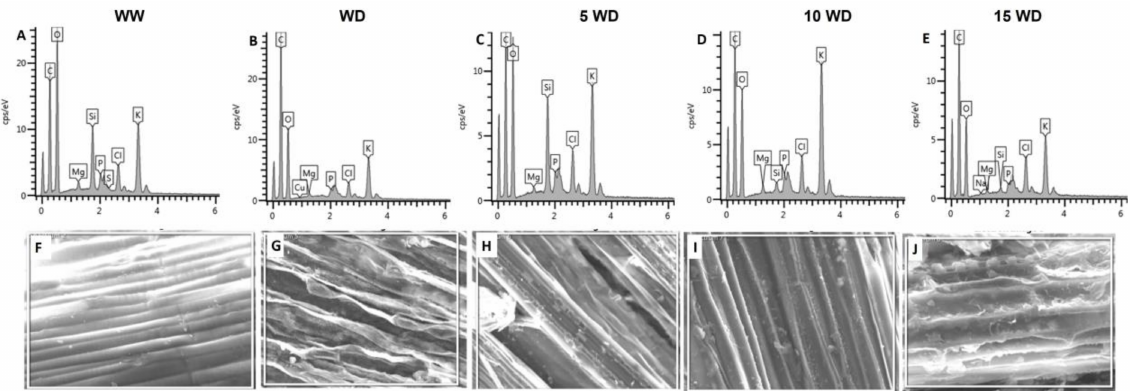
Figure 5. Effect of α Fe 2 O 3 NP priming on the element distribution in sorghum plants under drought stress: EDX spectroscopy showing the element distribution in sorghum plants ( A – E ); SEM micro- graphs for the EDX-investigated area ( F – J ). WW = well-watered (control); WD = water-deprived (drought stress); 5 WD = water-deprived + 5 mg/L α Fe 2 O 3 NPs; 10 WD = water-deprived + 10 mg/L